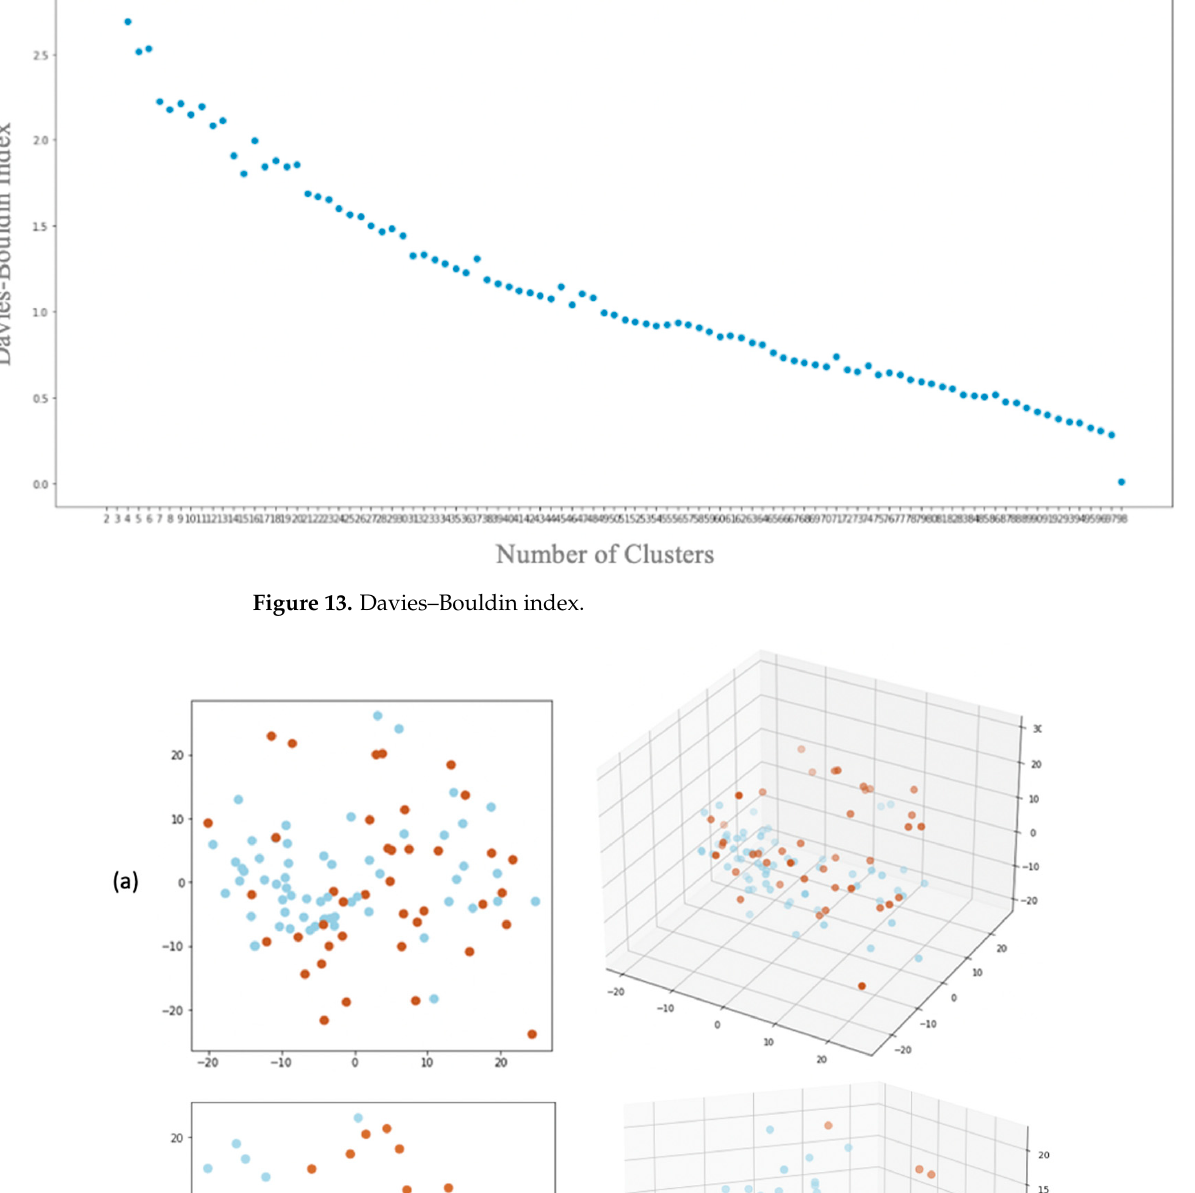
Figure 12. Silhouette average score.